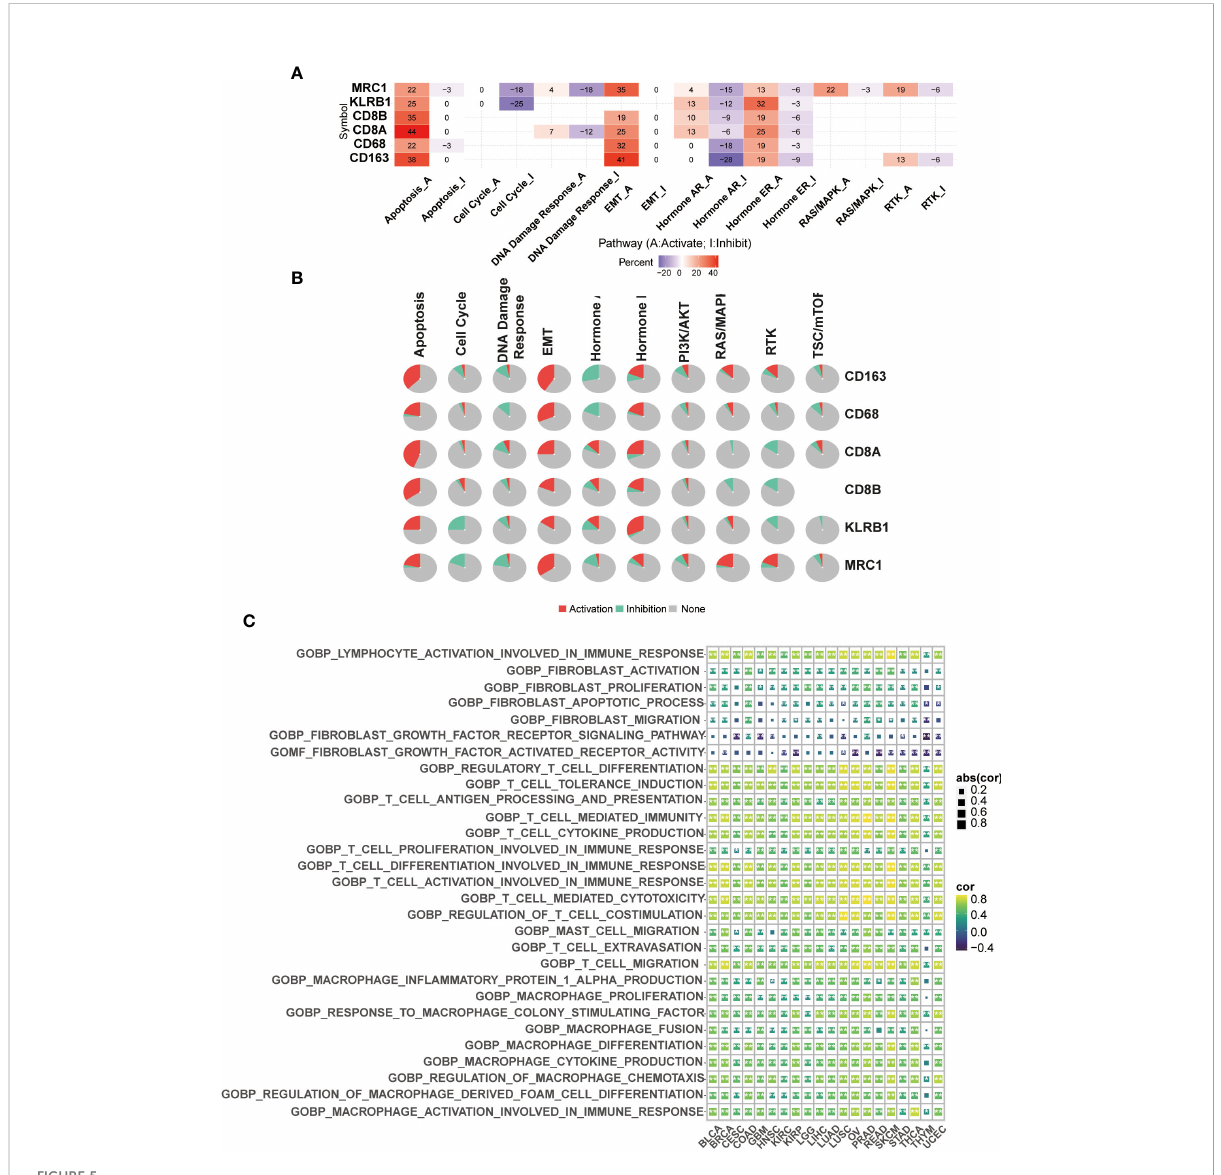
FIGURE 5 CD161 network. Venn diagram of CD161-binding genes (A) . Pathway enrichment of CD161 (B) . The GSVA algorithm was used to identify functional enrichment pathways of CD161 (C) . *P < 0.05; **P